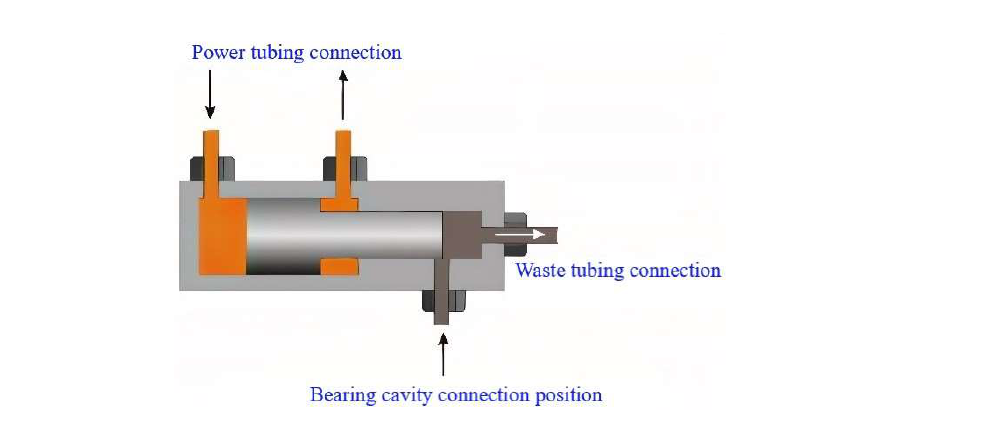
Figure 5. The working principle diagram of suction and drainer device for bearing of wind turbine.